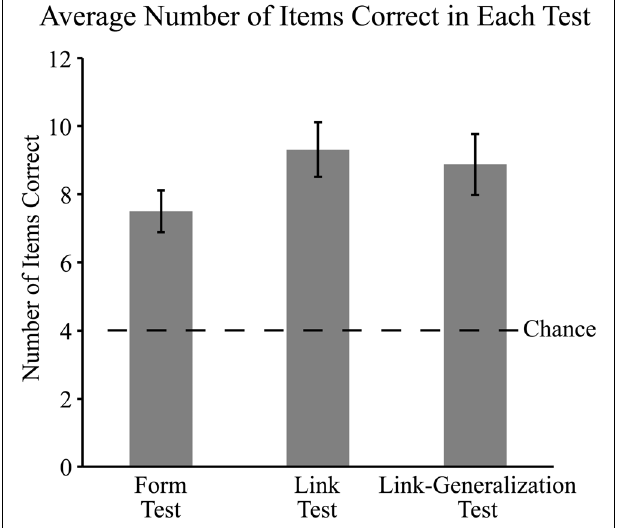
FIGURE 3 |Average number of items correct (out of 12) and standard errors in the form, link, and link-generalization tests. Children’s responses on all three tests were significantly above chance and children’s responses on the form test were significantly lower than responses on the link test.